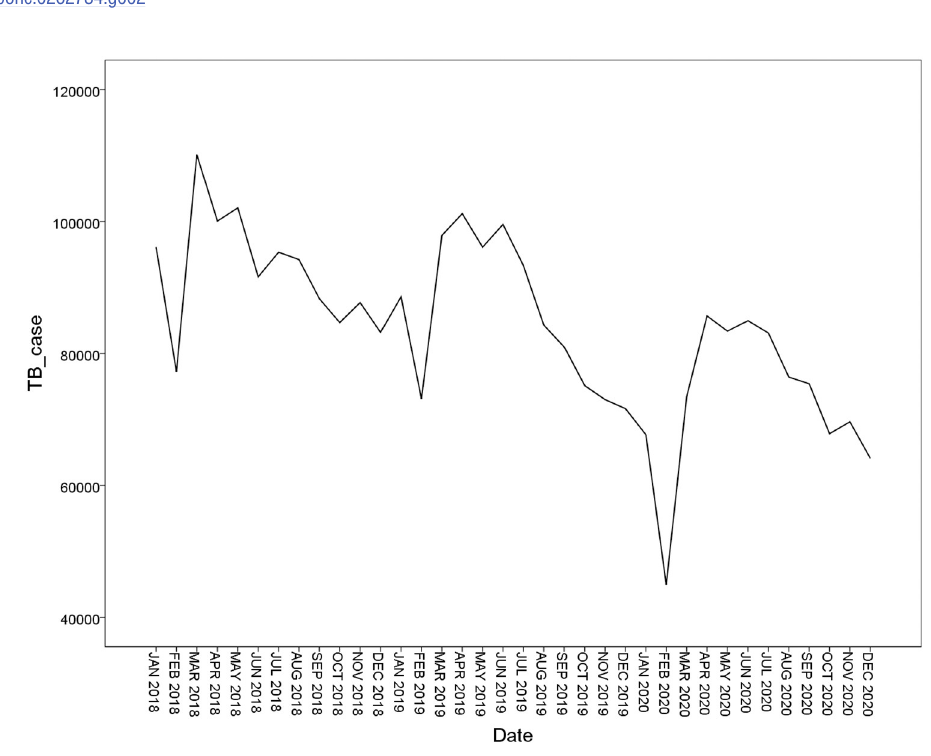
Fig 3. Plot of time series of original